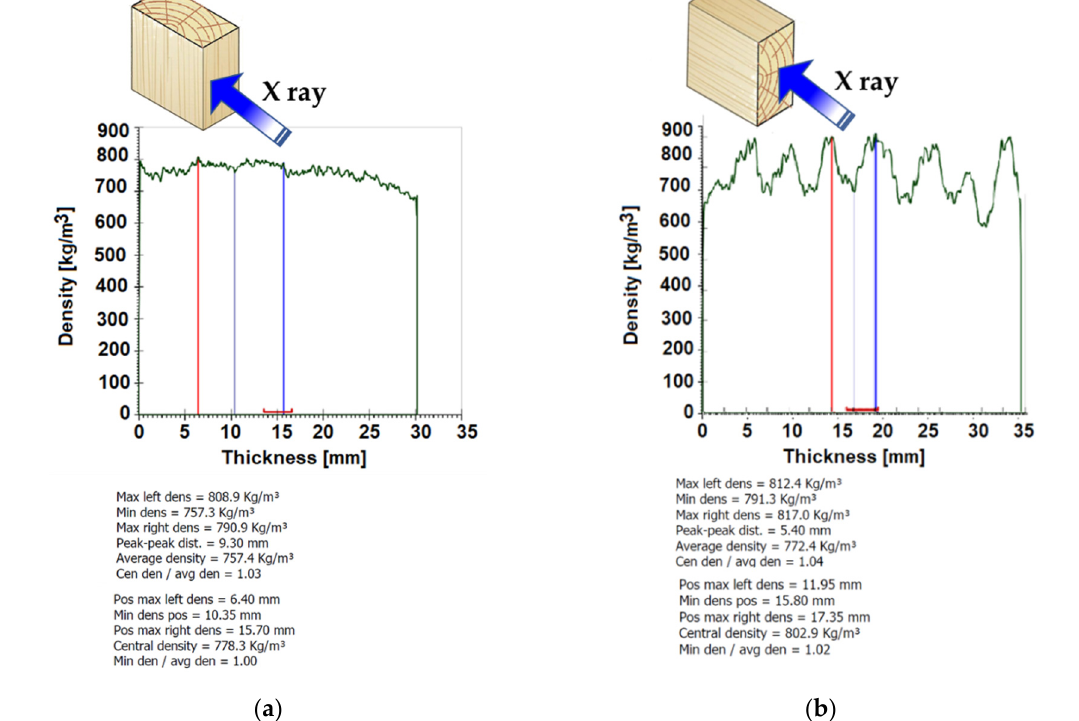
Figure 6. Variation of density profile of black locust wood samples: ( a ) longitudinal radial direction; ( b ) transversal direction of wood.